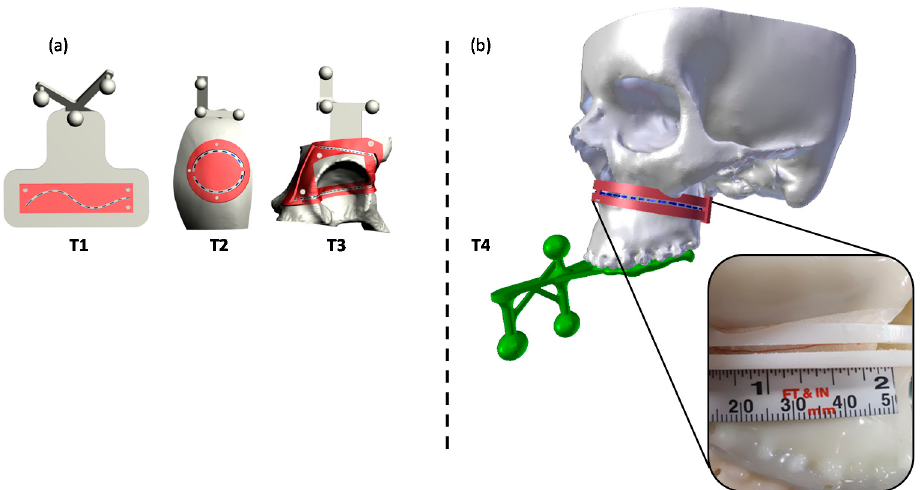
Figure 6. The tested T4 trajectory ( b ), specially related to the Le Fort 1 osteotomy surgical task, and the previously tested generic 3D trajectories T1–T3 ( a ). Trajectories are depicted in blue dashed lines, while the corresponding templates are reported in red, with the inspection window (IW) used to quantify the accuracy level.